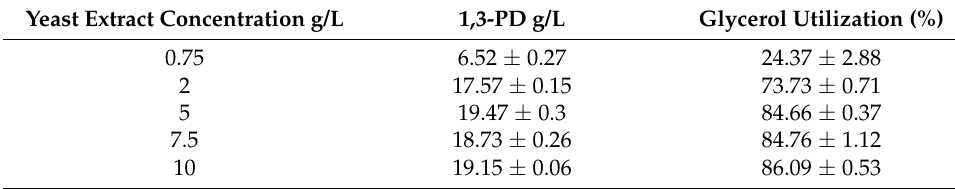
Table 5. Effect of yeast extract concentration on 1,3-PD production C. freundii